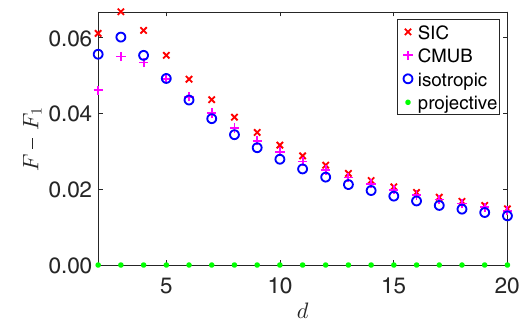
FIG. 2. Shifted two-copy estimation fidelities F = F ( A ⊗ 2 ) , where A is a measurement constructed from an orthonormal basis (projective), SIC, CMUB, or Haar random pure states (isotropic). Here F 1 = 2 /( d + 1 ) is the one-copy estimation fidelity achieved by a rank-1 projective measurement (or any rank-1